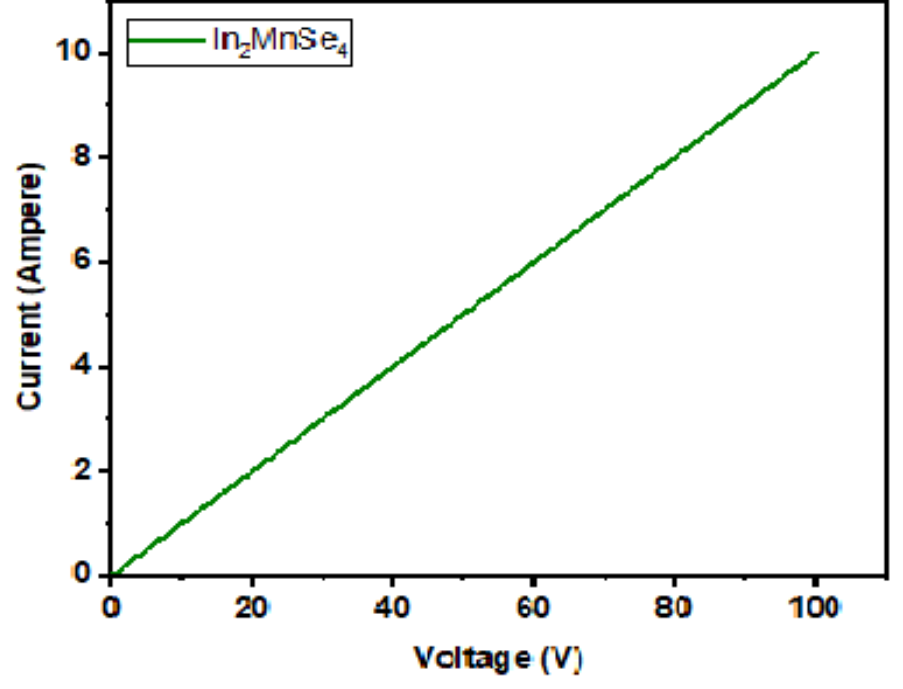
Figure 5. I ‐ V polarization curve of In 2 MnSe nanostructure. Figure 5. I–V polarization curve of In 2 MnSe